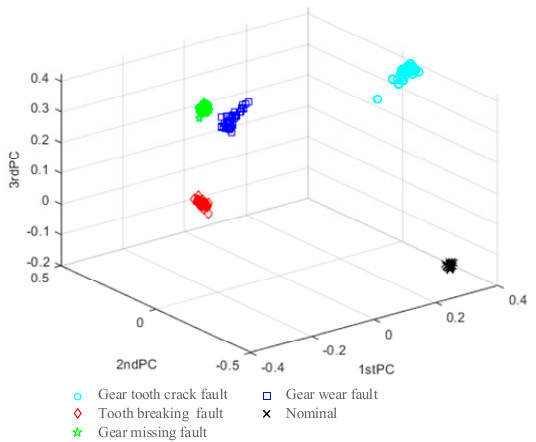
Figure 13. Clustering result of wavelet entropy under condition 3.